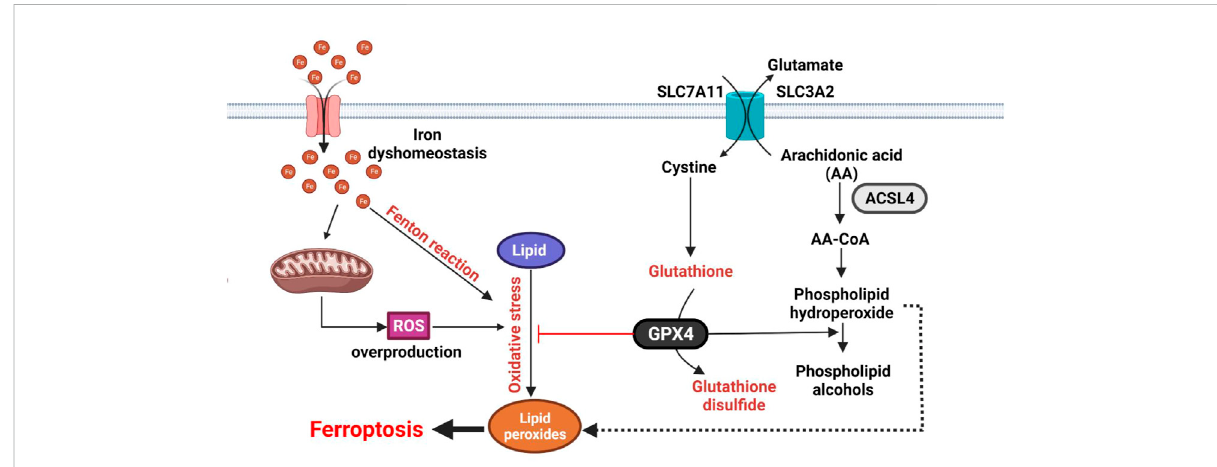
FIGURE 2 Molecular mechanisms of ferroptosis. Ferroptosis is characterized by oxidation of lipids upon inhibition of SLC7A11/SLC3A2 (Xc- system) transport complex or GPX4 activity. The reaction involved ROS and Fe 2+ . Ferroptosis is initiated by inhibition of the SLC7A11/SLC3A2 (Xc- system) transport complex or GPX4 activity. ROS and Fe 2+ directly catalyze lipid peroxides to form damaging free radicals via the Fenton reaction. The SLC7A11/SLC3A2antiporterisresponsible for GSLbiosynthesisbyimportingcystineinto cytosol. GPX4inhibitsferroptosisbytransforminglipid peroxides into lipid